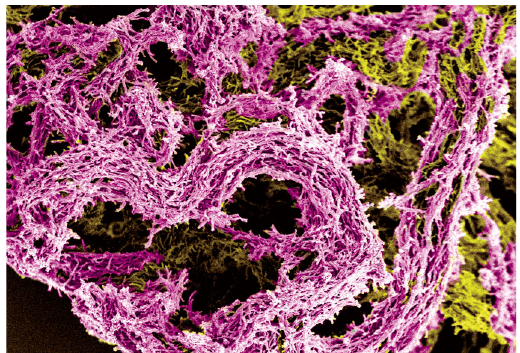
Fig. 5 Mycobacterial cording as a bio fi lm in detergent-free liquid media. A false-colour scanning electron microscopy image of M. bovis BCG grown in detergent-free liquid media (magni fi cation ×1000), exemplifying the dense cording phenotype that may better represent M. tb lung lesion growth, which is quite different from single cells found in liquid media containing